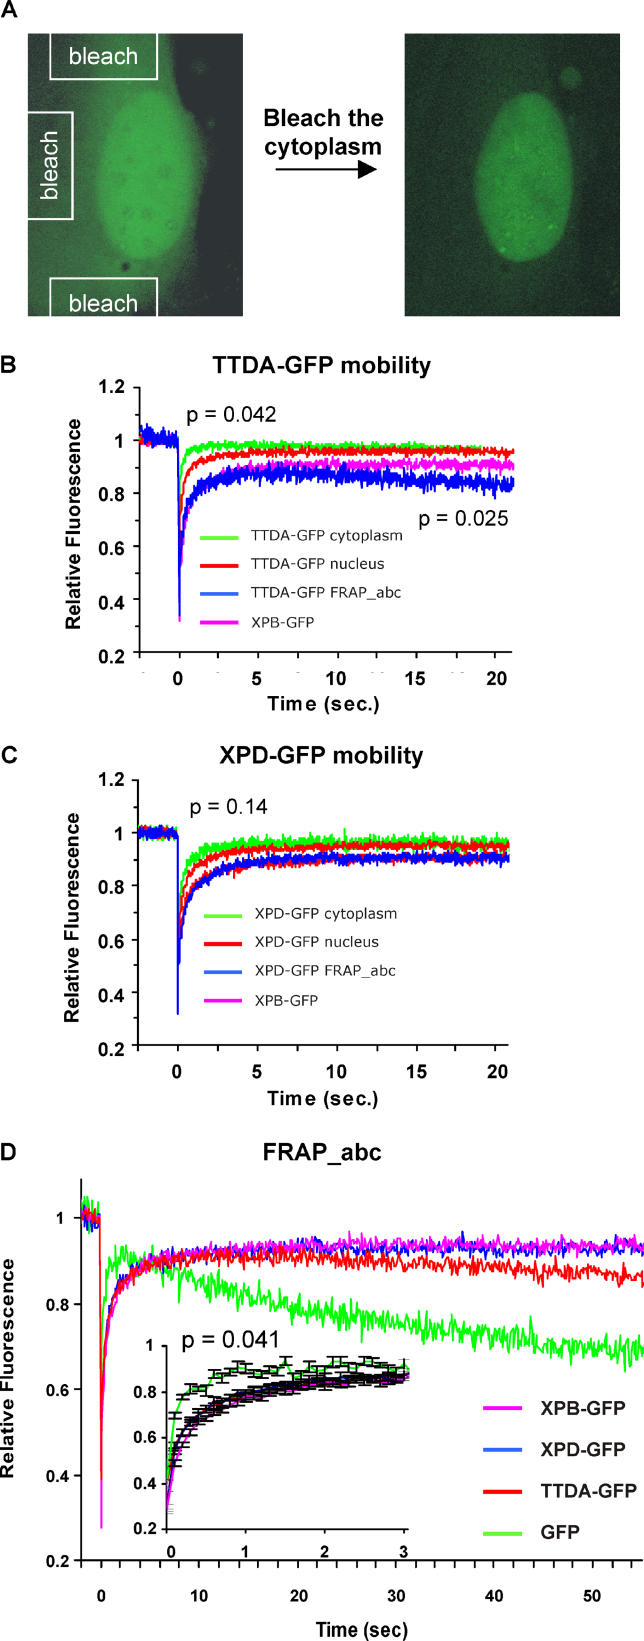
FRAP_abc(A) TTDA-GFP-expressing fibroblast without treatment (left panel) and after (right panel) applying several high laser pulses in the cytoplasmic compartment (see
Materials and Methods for details).
(B) TTDA-GFP mobility in the cytoplasm (green line), in the nucleus without bleaching the cytoplasm (red line), in the nucleus after bleaching the cytoplasmic fraction (blue line), and XPB-GFP mobility in the nucleus (pink line). The
p-value has been calculated for cytoplasmic and nuclear mobility curves of TTDA-GFP.
(C) XPD-GFP mobility in the cytoplasm (green line), in the nucleus without bleaching the cytoplasm (red line), in the nucleus after bleaching the cytoplasmic fraction (blue line), and XPB-GFP mobility in the nucleus (pink line). The
p-value has been calculated for cytoplasmic and nuclear mobility curves of XPD-GFP.
(D) FRAP_abc on XPB-GFP (pink line), XPD-GFP (blue line), TTDA-GFP (red line), and free GFP (green line). Inset shows increased time resolution of the curves with error bars.